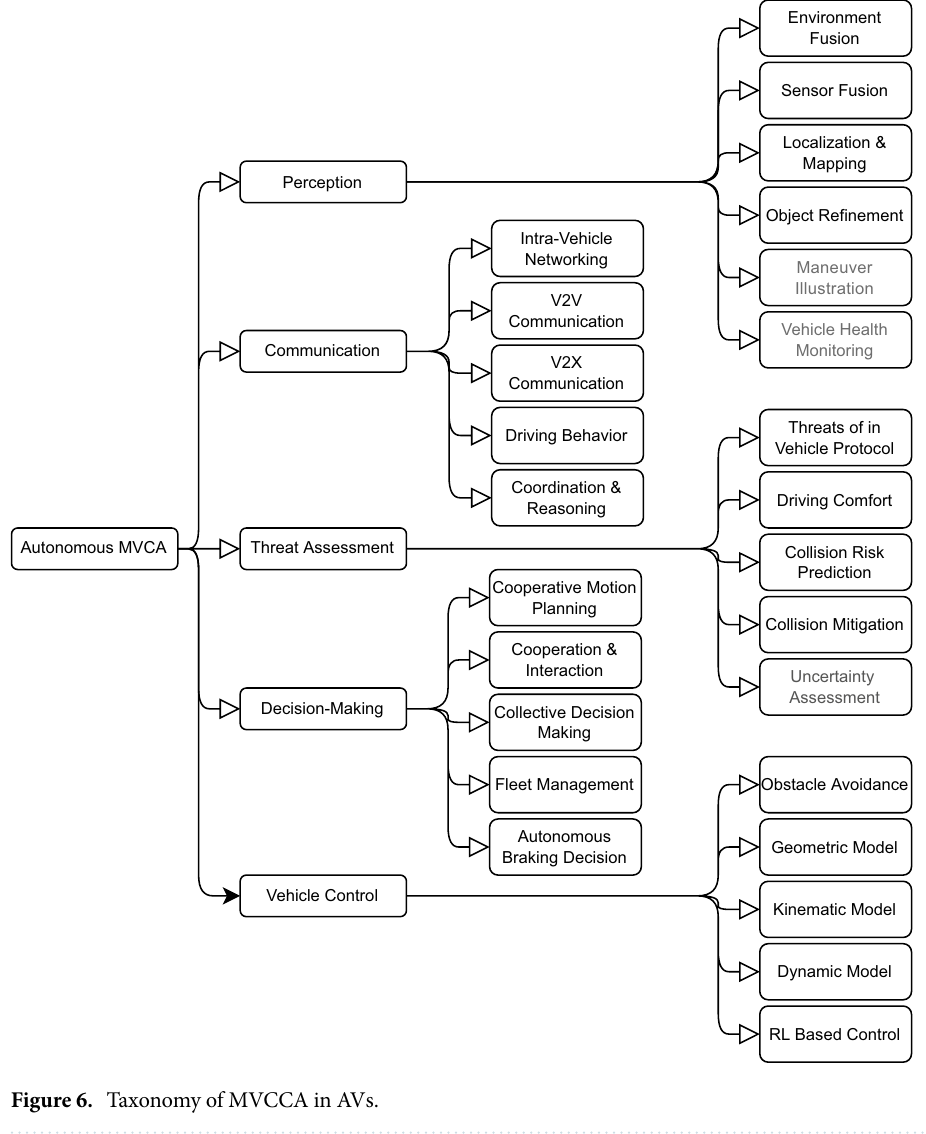
Figure 6. Taxonomy of MVCCA in